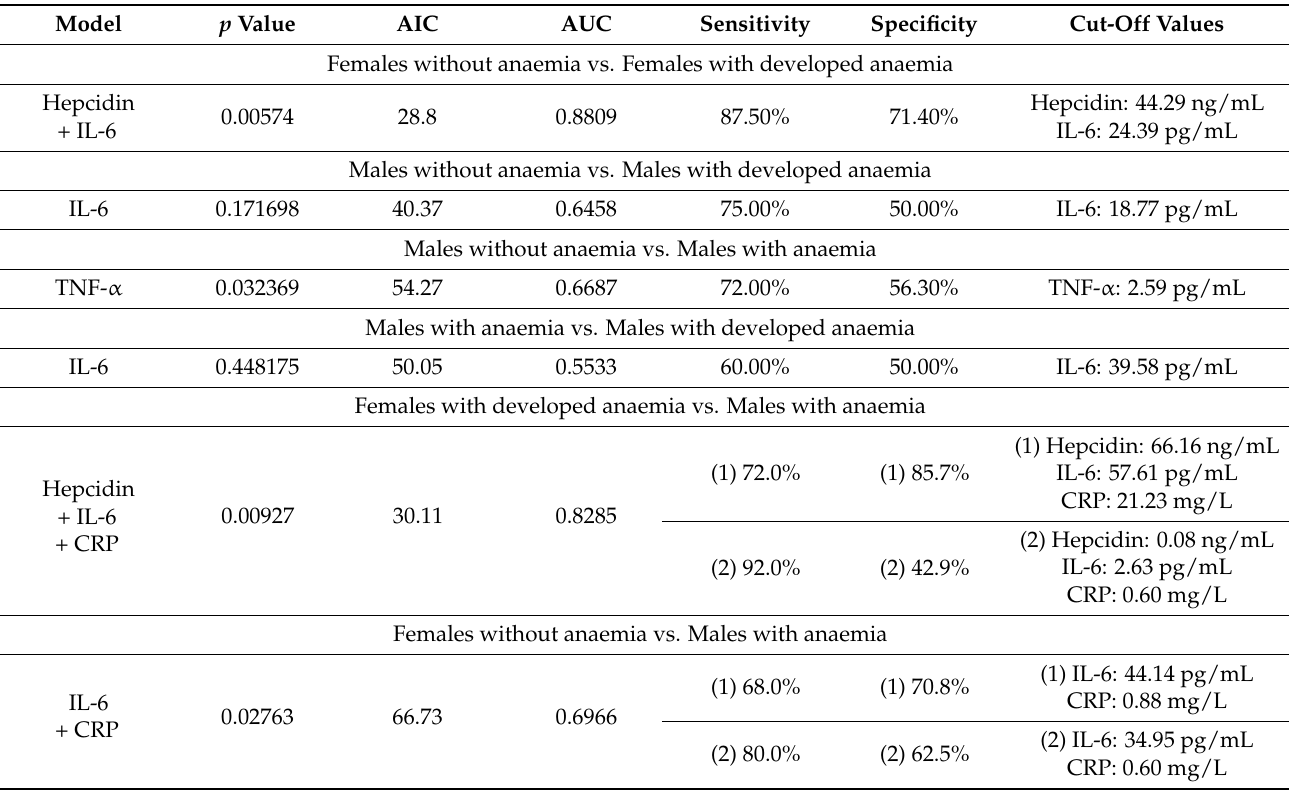
Table 7. The diagnostic efficiency of biomarker models to differentiate lung cancer patients without anaemia, patients with anaemia since the day of hospitalization, and patients who developed anaemia during their hospitalization based on patient